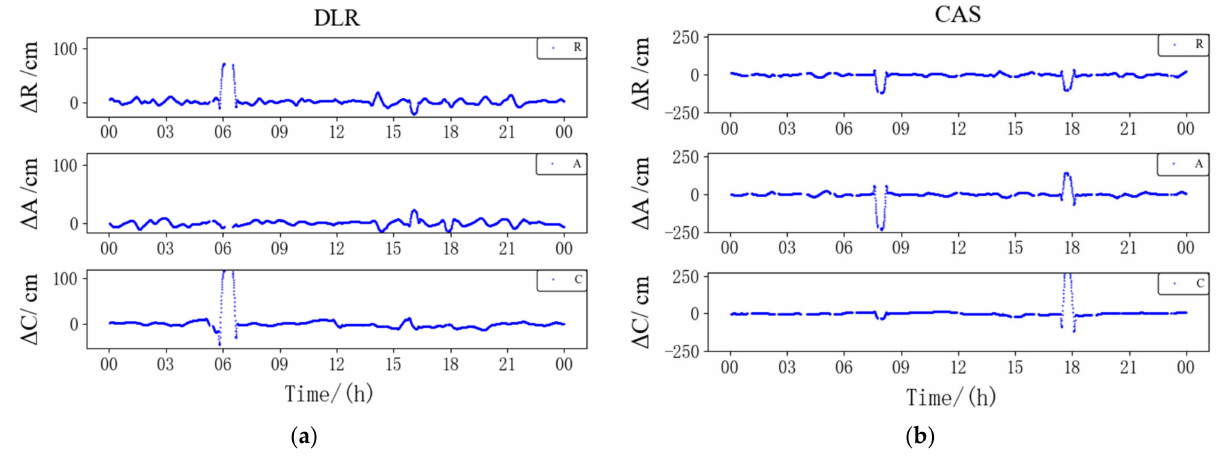
Figure 9. Orbit differences of GRCC kinematic results with JPL POE in the R, A, and C directions: ( a ) DLR result for DOY 147 of 2022; ( b ) CAS result for DOY 147 of